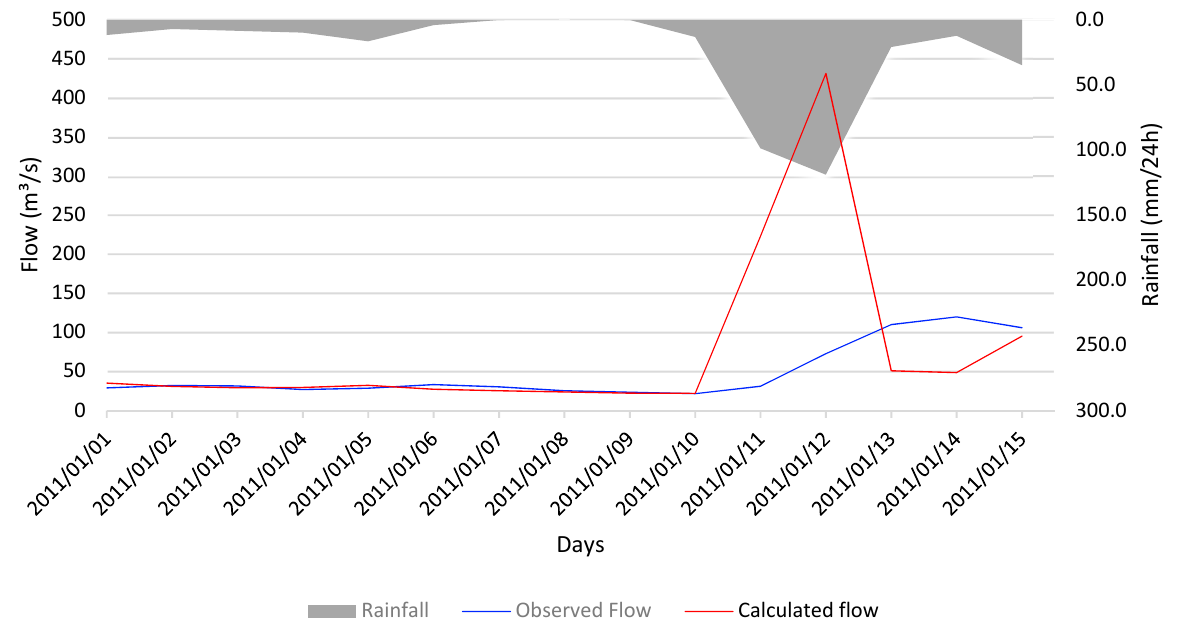
Figure 9. Comparison between estimated and simulated SWAT flow in the validation defined by the left axis, while the right axis represents daily precipitation.